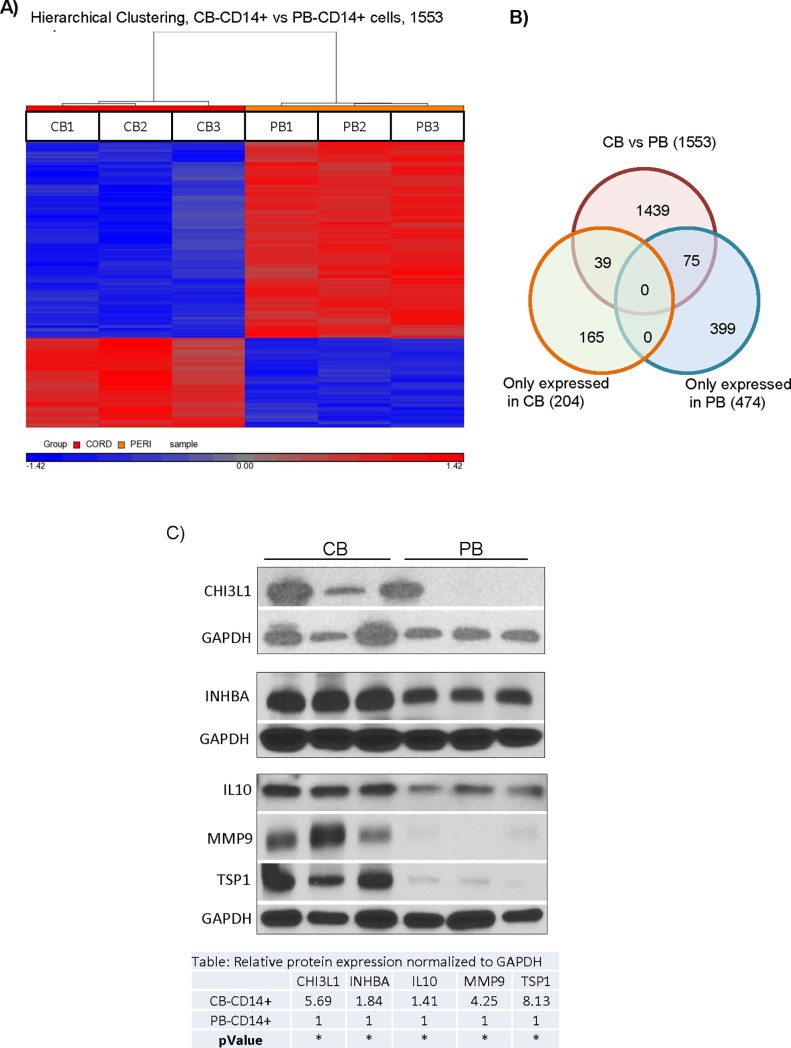
Identification of secretory proteins expressed by CB CD14+ cells that may mediated protections against OGD.(A) Comparative whole transcriptome analysis of CB-CD14+ and PB-CD14+ cells. Heat maps from Experiment 1213 showing differentially expressed probes in CB (CB-CD14+) and PB (PB-CD14+) cells. Up and downregulated genes are displayed in red and blue, respectively. RMA analysis detected significantly (p<0.05) different expression (at least two-fold) of probe sets corresponding to 1553 genes. (B) Gene expression comparisons between CB-CD14+ and PB-CD14+ cells by Venn diagram. Genes in overlapping sets show the differential expression in two or three comparison pairs. (C) Protein expression analysis of CB-CD14+ and PB-CD14+ cells. a) Lane 1–3, represent three different samples (n = 3) of CB-CD14+ cells and Lane 4–6 represent, three different samples (n = 3) of PB-CD14+ cells. The results confirmed enrichment of CH3L1, INHBA, IL-10, matrix metalloproteinase-9 (MMP9) and TSP1 in CB-CD14+ relative to PB-CD14+ monocyte homogenates. GAPDH was used as loading control. Quantitative expression of each proteins is shown in the table. Statistical significance (p< 0.05) is shown by asterisks.